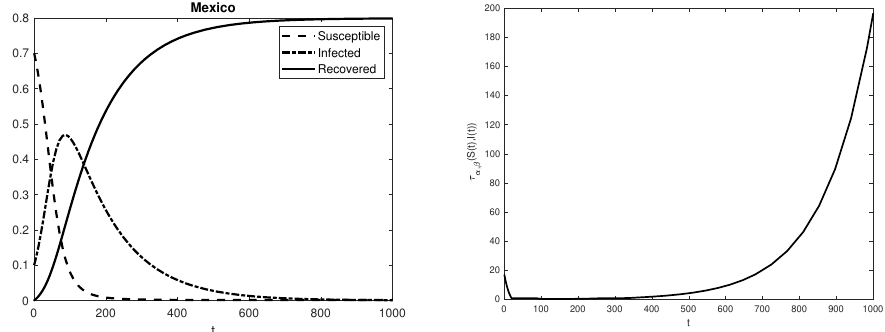
Figure 6. Solution to the SIR model (1), with initial value given by the vector (4), for Mexico ( left ) and corresponding pattern of τ α , β ( S ( t ) , I ( t )) ( right